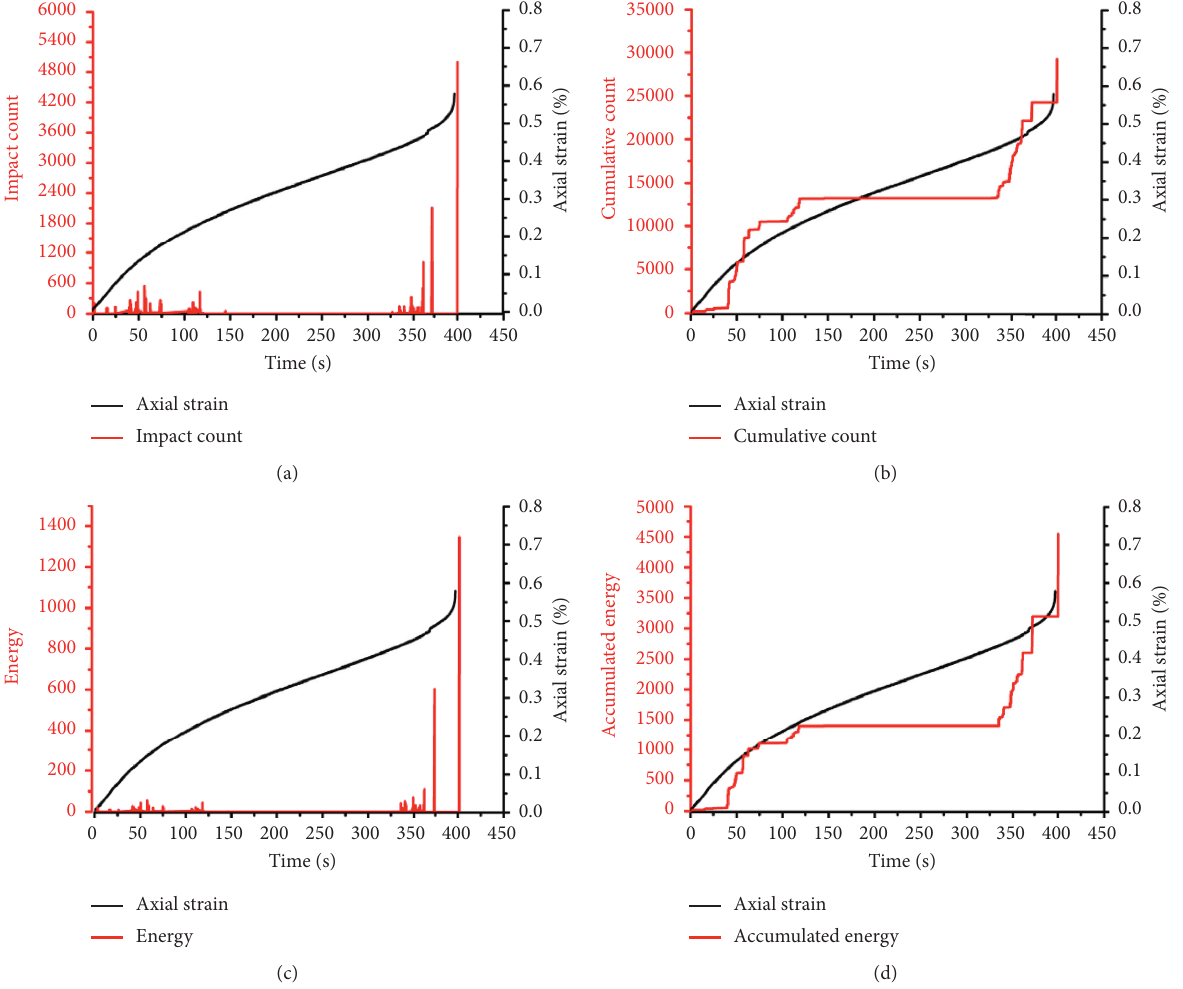
Figure 9: Deformation and acoustic emission characteristics of C-70-1 sample. (a) The curves of ringing count and axial strain of C-70-1 sample with time. (b) The curves of cumulative ringing count and axial strain of C-70-1 sample with time. (c) The curves of energy and axial strain of C-70-1 sample with time. (d) The curves of cumulative energy and axial strain of C-70-1 sample with